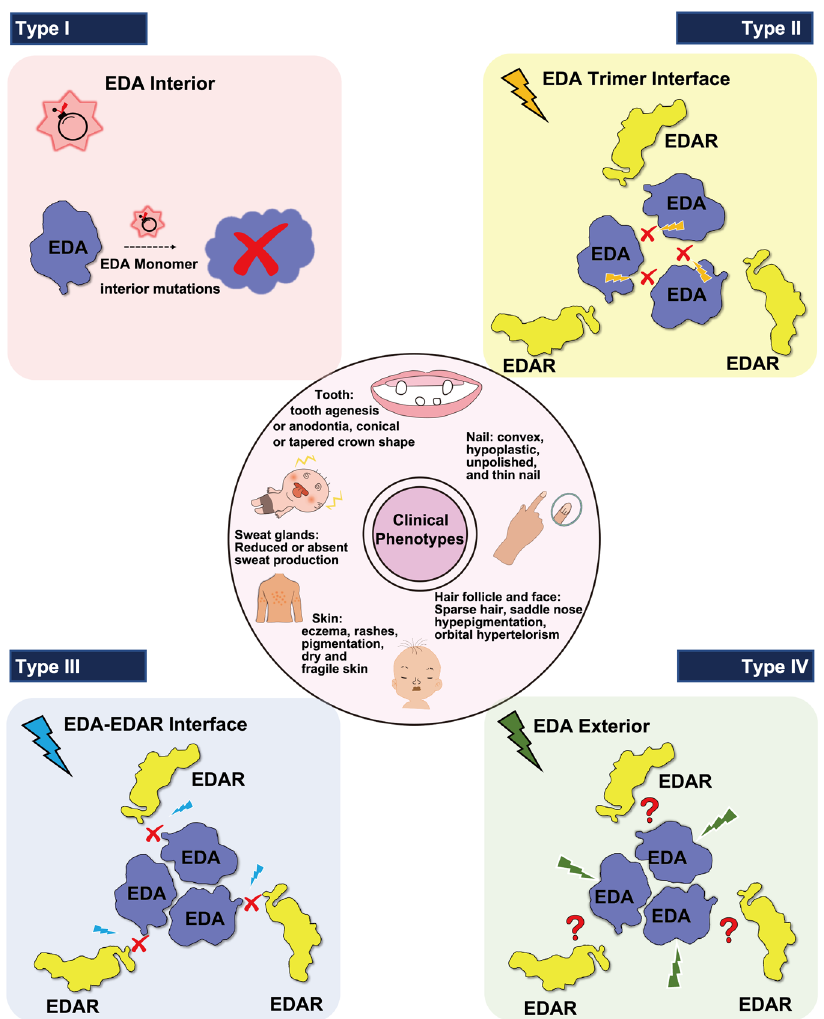
Fig. 8 | Summary of missense mutations in EDA·A1 THD . The pathogenic mutations that cause ectodermal dysplasia (middle circle) can be divided into four distinct categories (type I, II, III, and IV) with different locations in EDA·A1 THD and distinct clinical